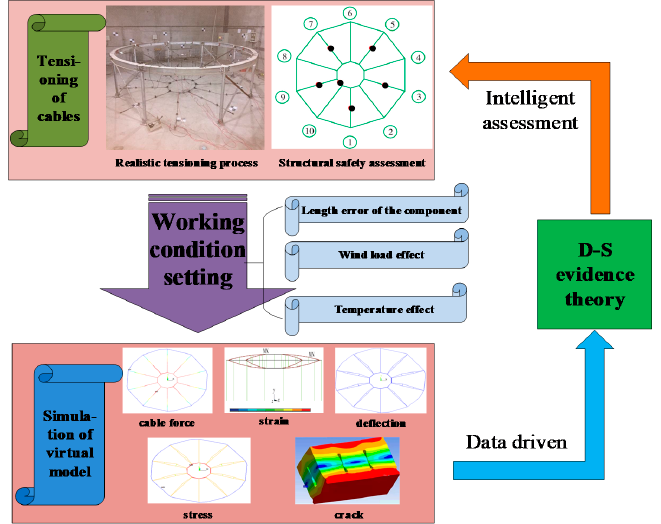
Figure 3. Intelligent discriminative framework for mechanical parameter sen- sitivity driven by digital